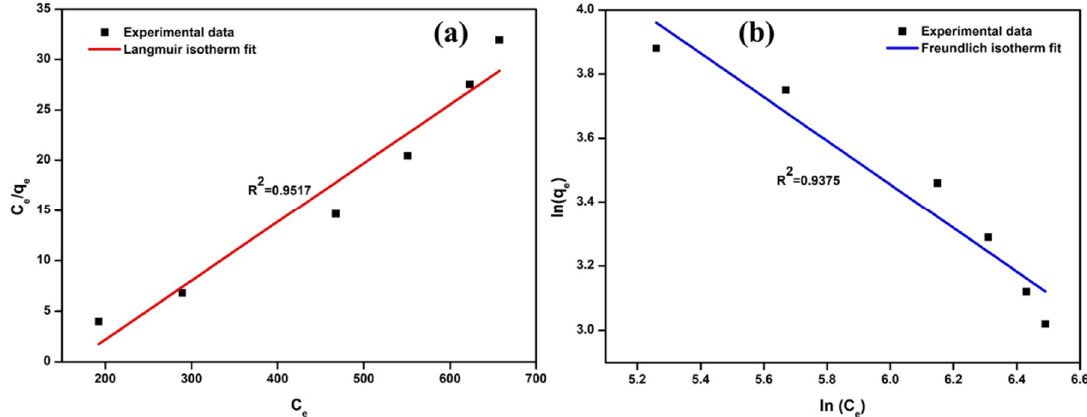
Figure 4. Adsorption isotherms: ( a ) The Langmuir isotherm for an adsorbent dosage of 2.5 g; and ( b ) the Freundlich isotherm for an adsorbent dosage of 2.5 g.